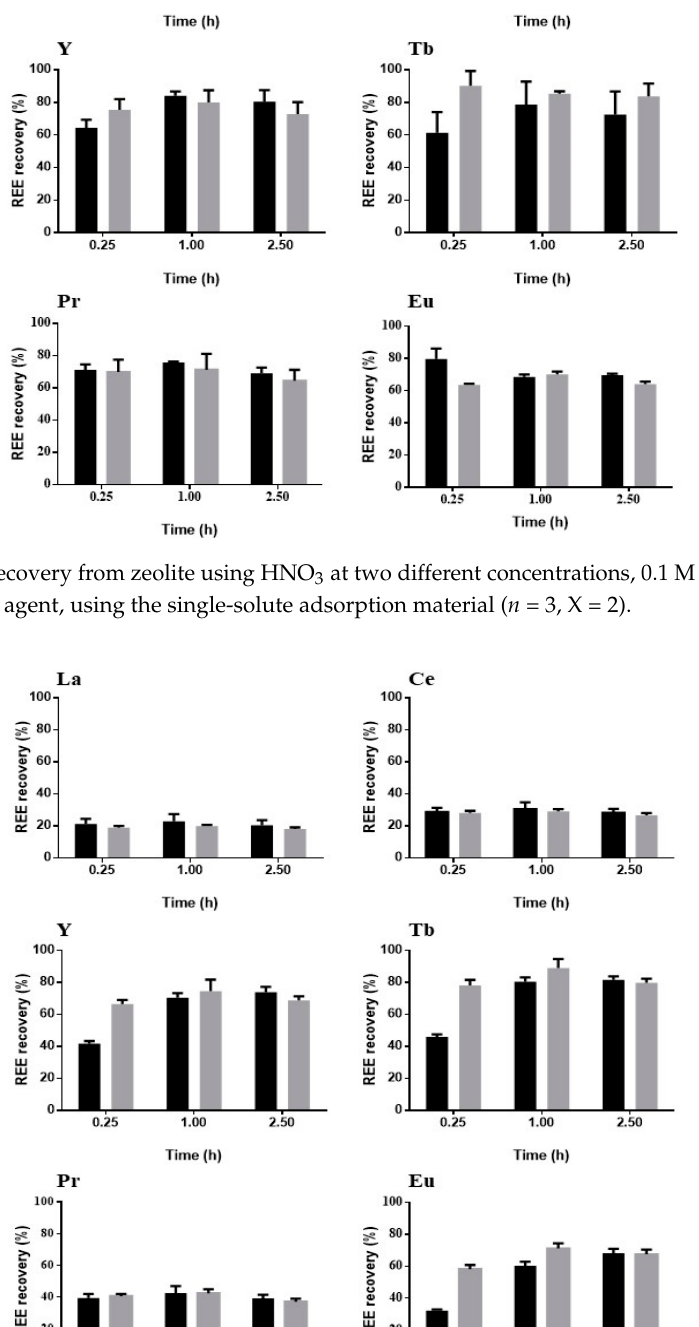
Figure 8. REE recovery from zeolite using HNO 3 at two different concentrations, 0.1 M ( ) and 0.5 M